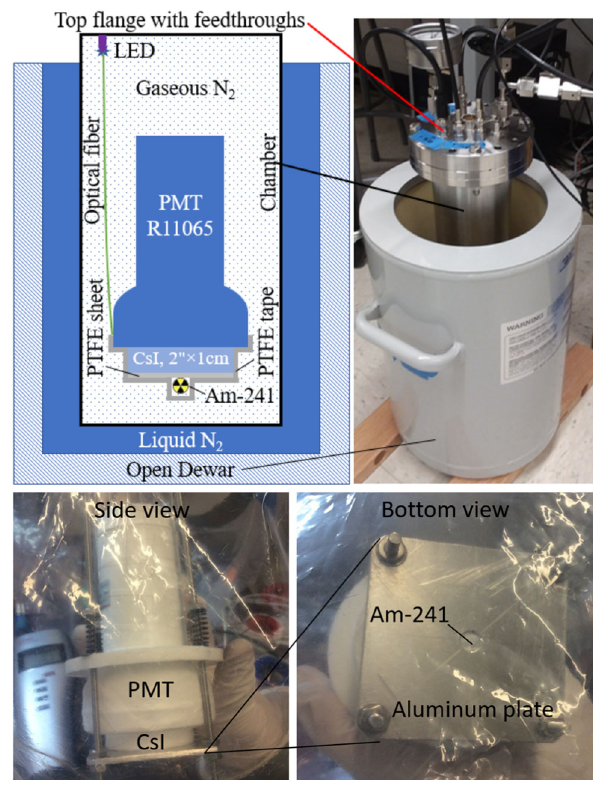
Fig. 1 A sketch and pictures of the experimental